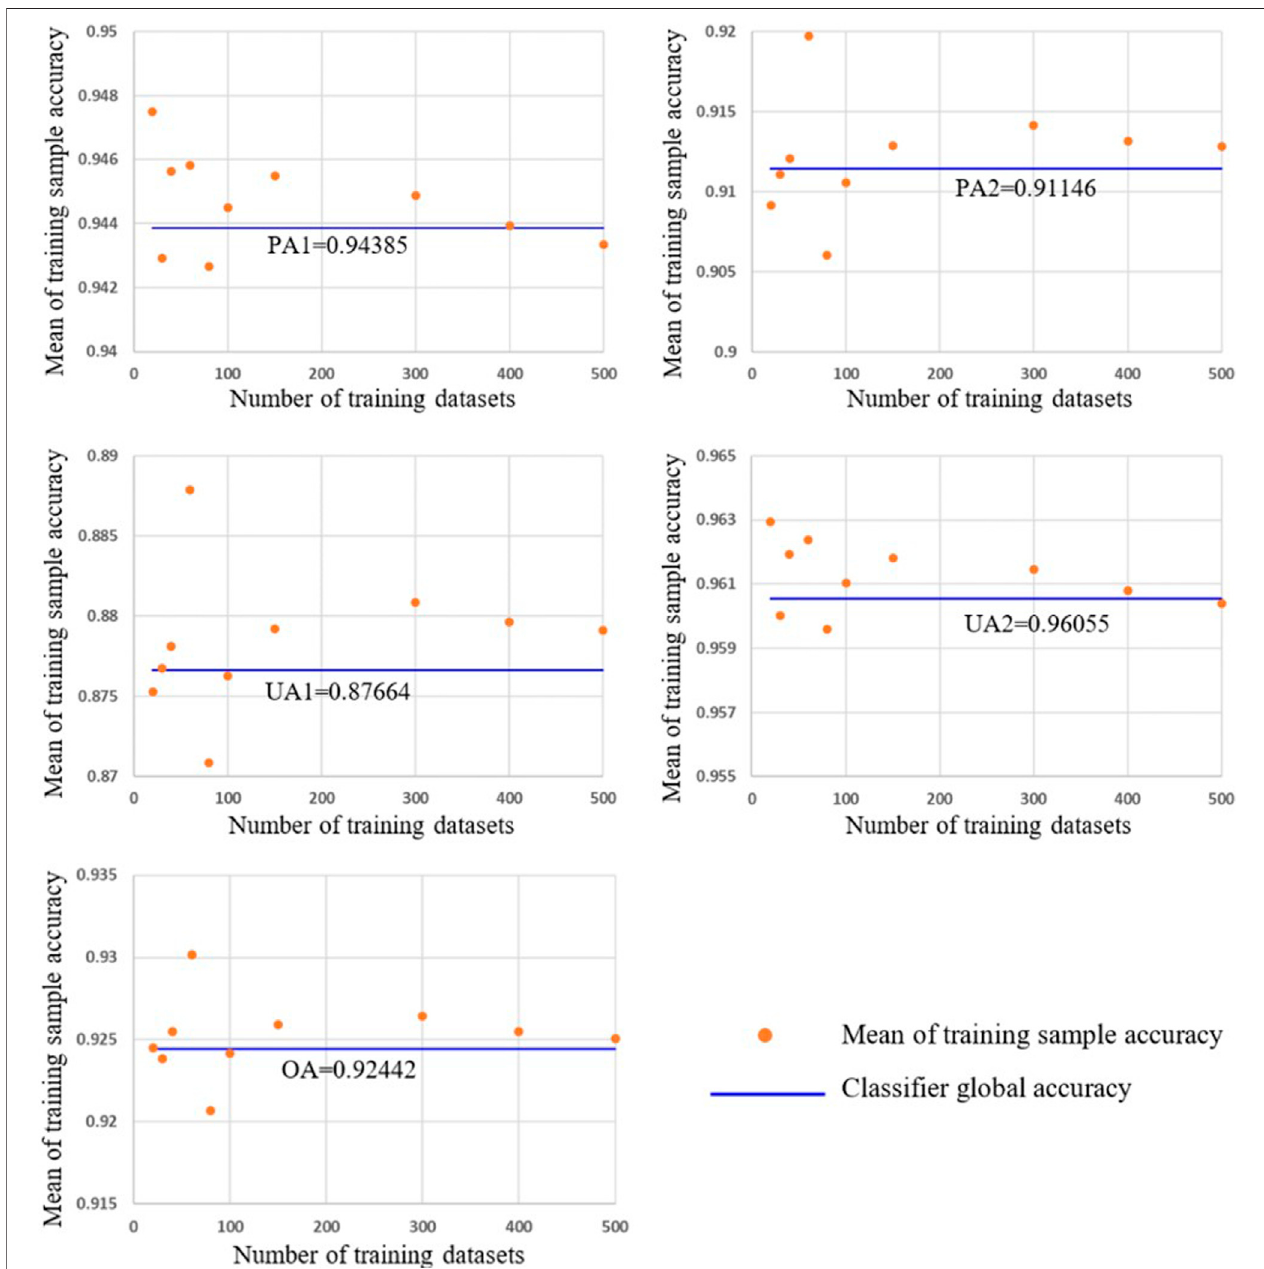
FIGURE6| Asymptoticbehaviorofthemeantrainingsampleclassi fi cationaccuracies.Themeantrainingsampleaccuracieswerecalculatedbasedon20,30,40, 60, 80, 100, 150, 300, 400, and 500 sets of training samples. Each training sample set is composed of 80 and 120 data points from C 1 and C 2 , respectively.